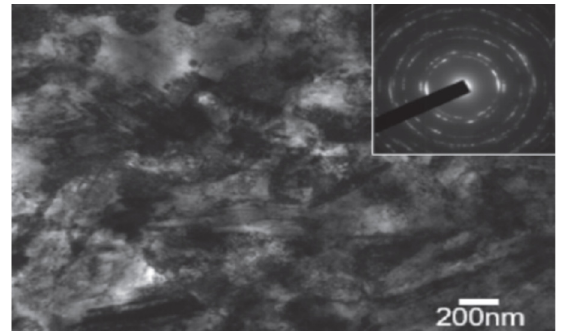
Figure 6. TEM micrograph presenting nanostructured grains developed during UNSM on Inconel 690. Reprinted with permission from ref. [93]. Copyright 2018, Elsevier.